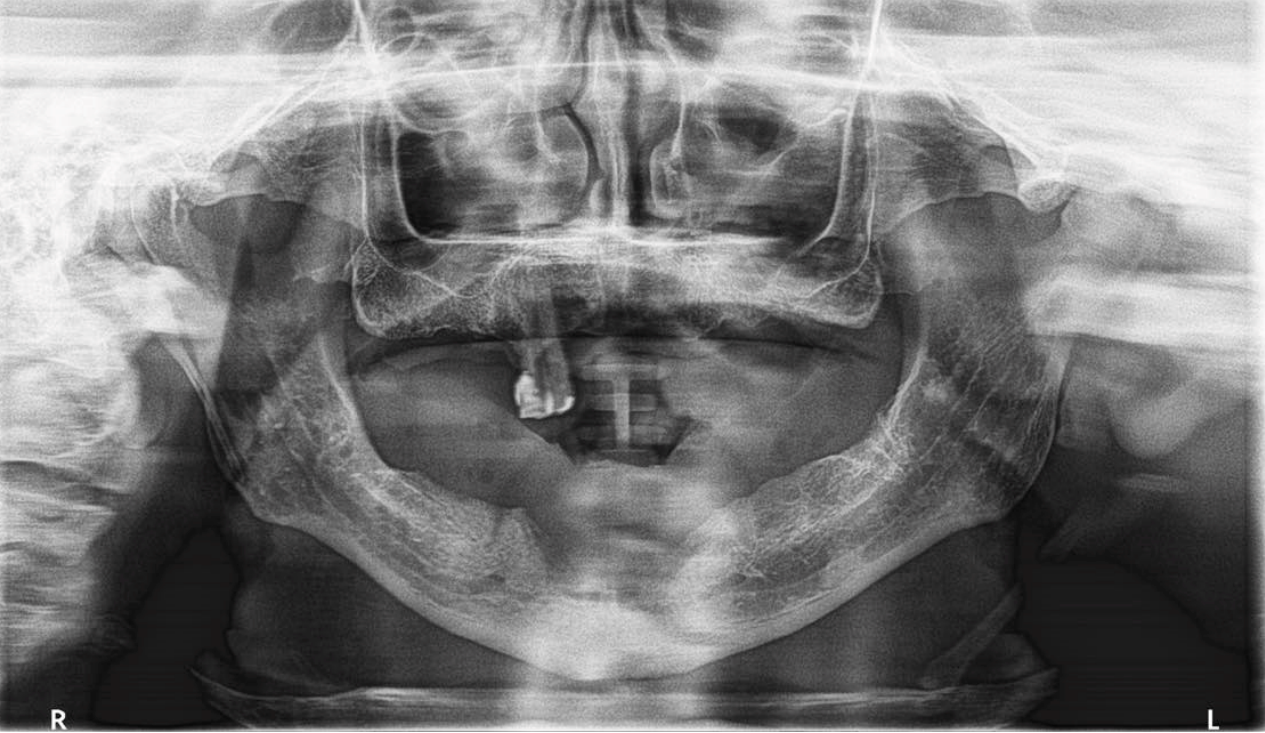
Figure 5. Postoperative control panoramic radiograph.